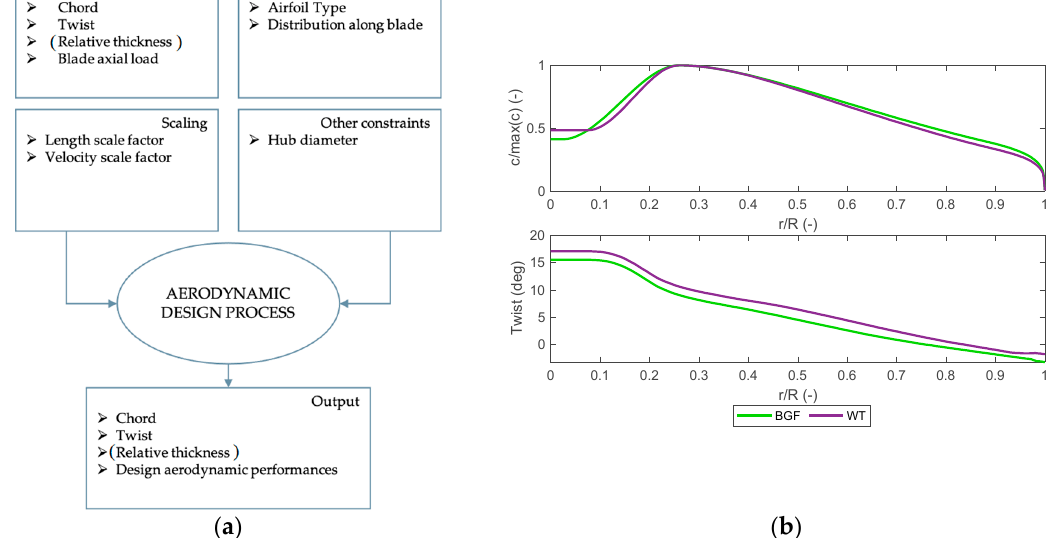
Figure 6. ( a ) Flow chart of the blade design process ( b ). Normalized chord and twist distribution of the outdoor prototype (BGF) and the wind tunnel model blade.